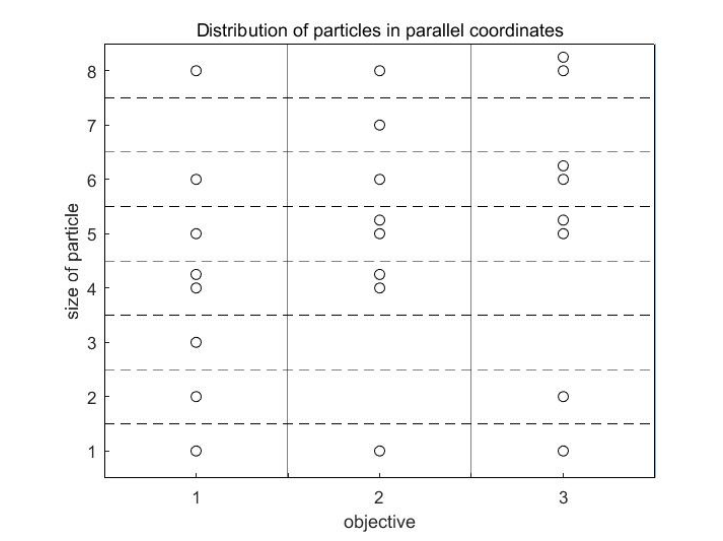
Figure 1. Particle distribution in parallel cell coordinates